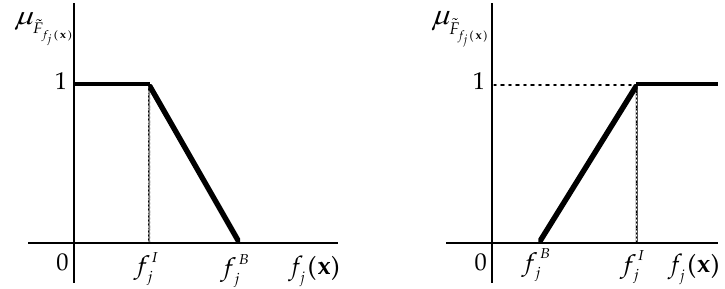
Figure 1. Membership functions of minimizing ( left ) and maximizing ( right ) fuzzy goals.